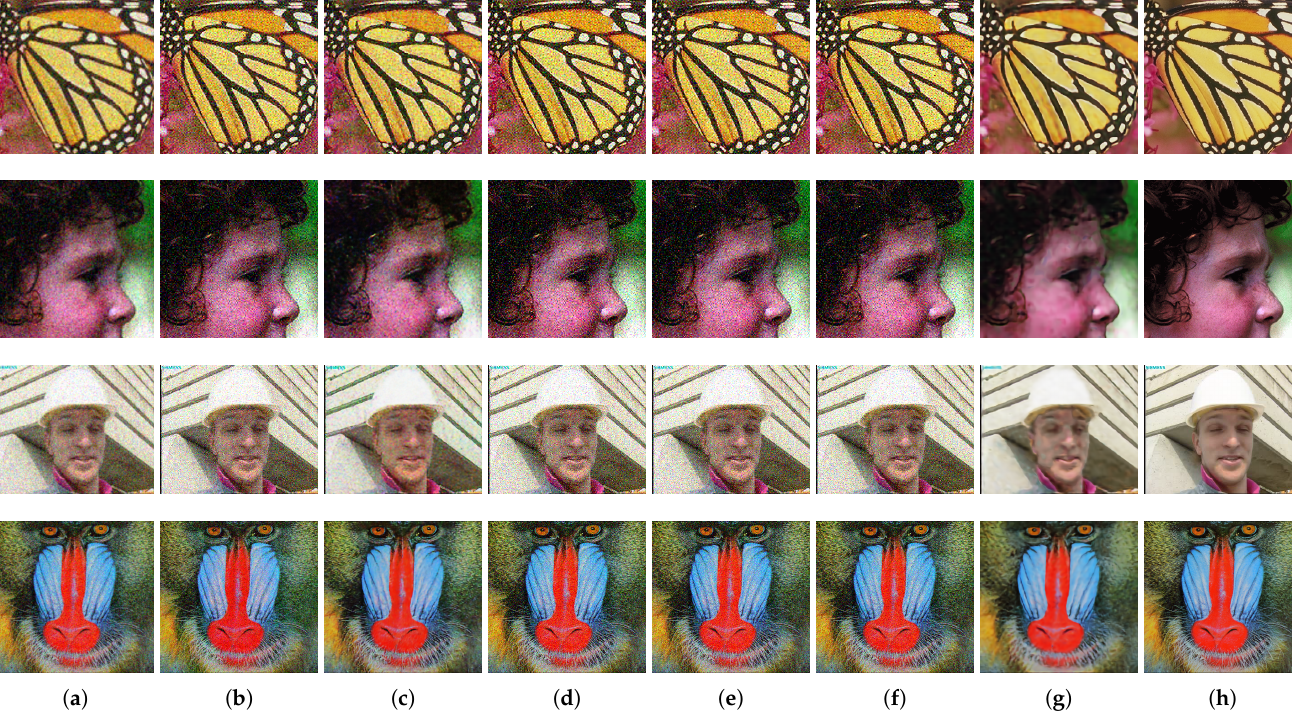
Figure 4. Qualitative comparisons of Set5 [11] and Set14 [12] ( × 2, σ = 25). ( a ) Bicubic, ( b ) DIP-SR [1], ( c ) DIP-Seq, ( d ) DRLN [22], ( e ) HAN [32], ( f ) SAN [33], ( g ) Ours and ( h ) Ground